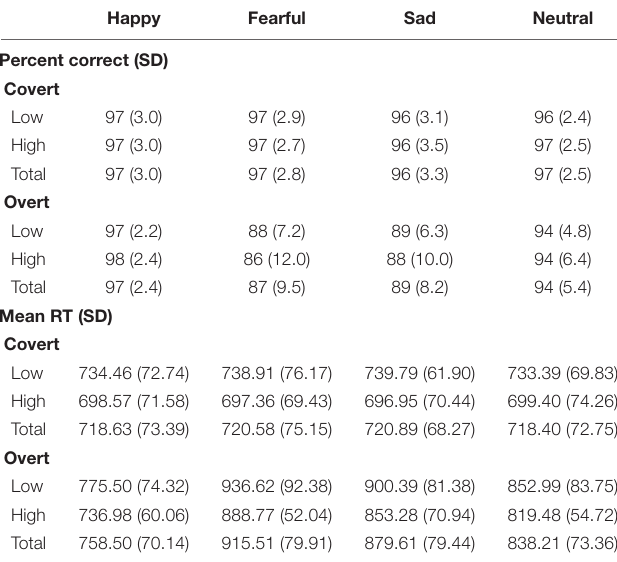
TABLE 1 | Mean accuracy and mean reaction time (in milliseconds) for the high and low dysphoria groups as a function of Task and Emotion. Happy Fearful Sad